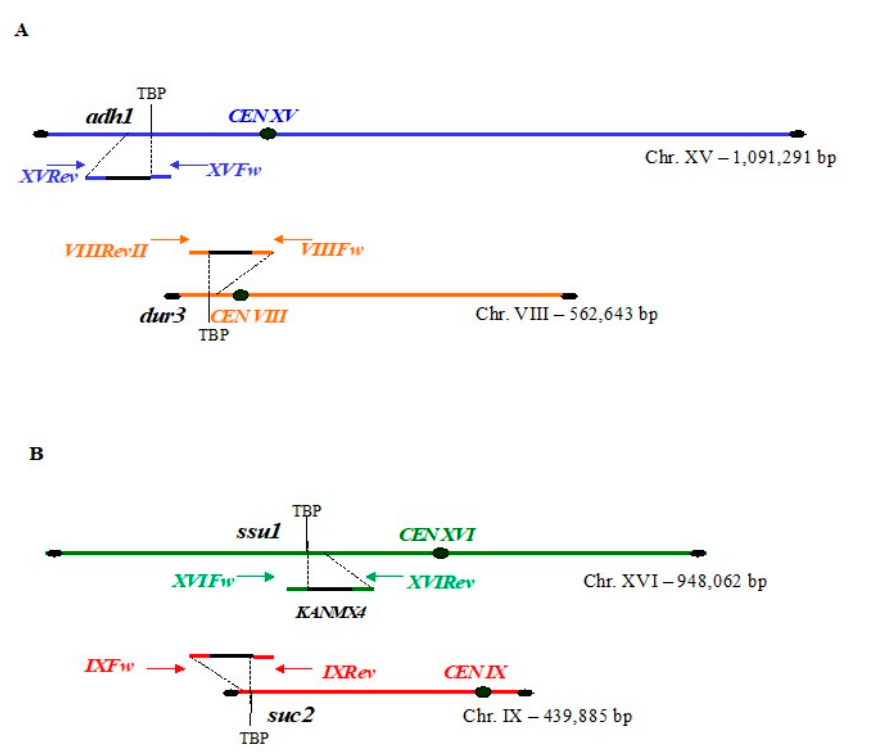
Figure 3. Schematic representation of the four events of Site-Specific Integration studied in this work. The precise position of each DNA cassette integrated on chromosome XV, VIII, XVI and IX (next to loci adh1 , dur3 , ssu1 and suc2 , respectively) is shown together with the primers used for the diagnostic amplifications (sequences in Table S1). ( A ) adh1 (chromosome XV, blue color) and dur3 loci (chromosome VIII, orange color) are shown. ( B ) ssu1 (chromosome XVI, green color) and suc2 (chromosome IX, red color) loci are shown. TBP: translocation breakpoint. CEN: centromere.